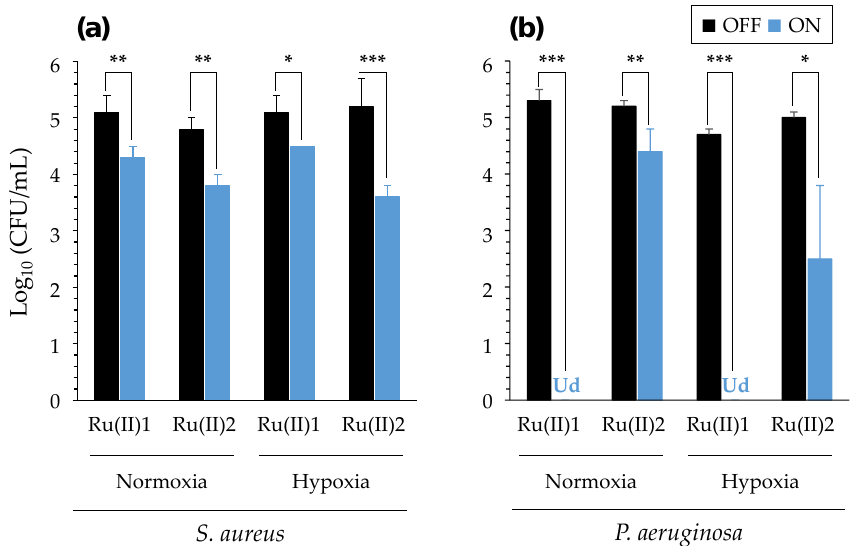
Figure 7. PDT effects of [Ru(II)] in normal or hypoxic media. Results were obtained with S. aureus RN4220 ( a ) and P. aeruginosa PA19660 ( b ). [Ru(II)]1 was 50 and 25 µ M, whereas [Ru(II)]2 was 0.1 and 1.25 µ M in 0.5X NaCl, when assaying S. aureus and P. aeruginosa , respectively. Mean ± SD with n = 3 (representative data of N = 4). ***, p -value ≤ 0.001; **, p -value ≤ 0.01; *, p -value ≤ 0.05. “Ud”: undetectable bacteria.